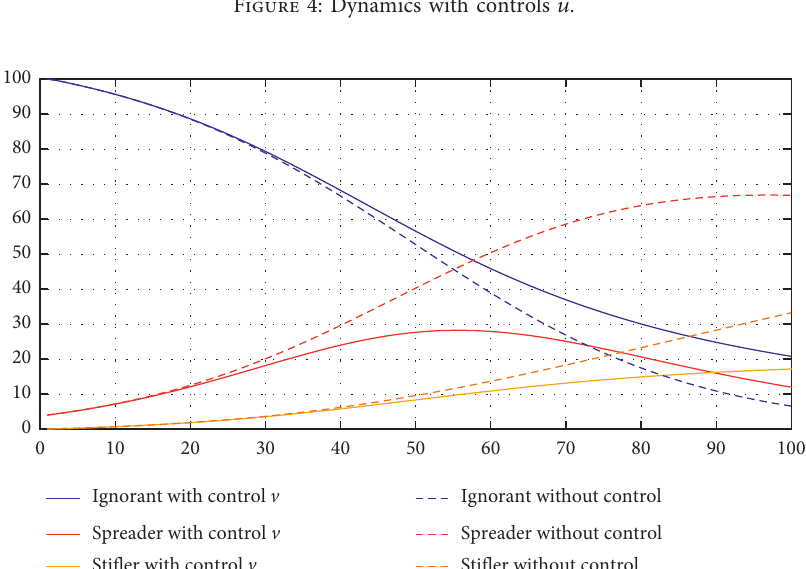
Figure 5: Dynamics with controls v .